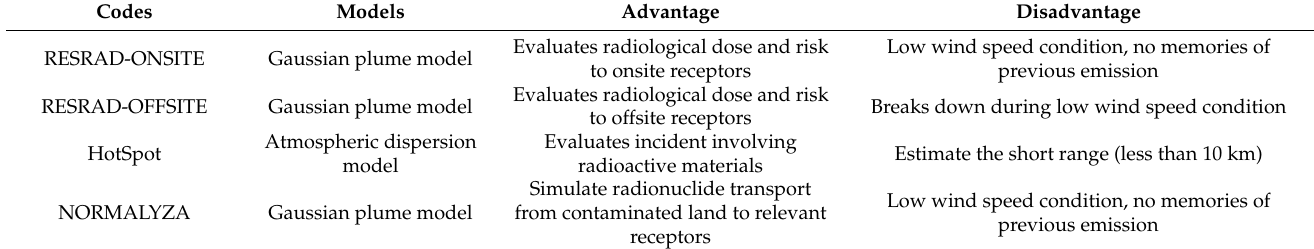
Table 3. Comparison of models used in this study.